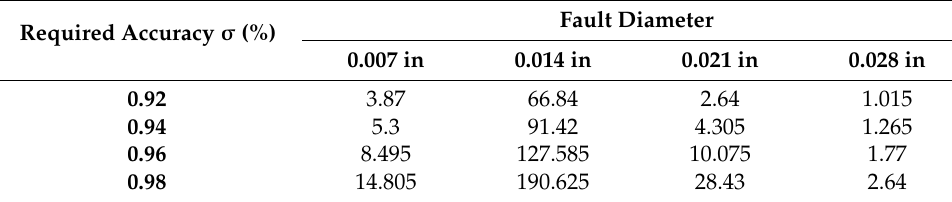
Table 5. The mean of the sampling number in group B.